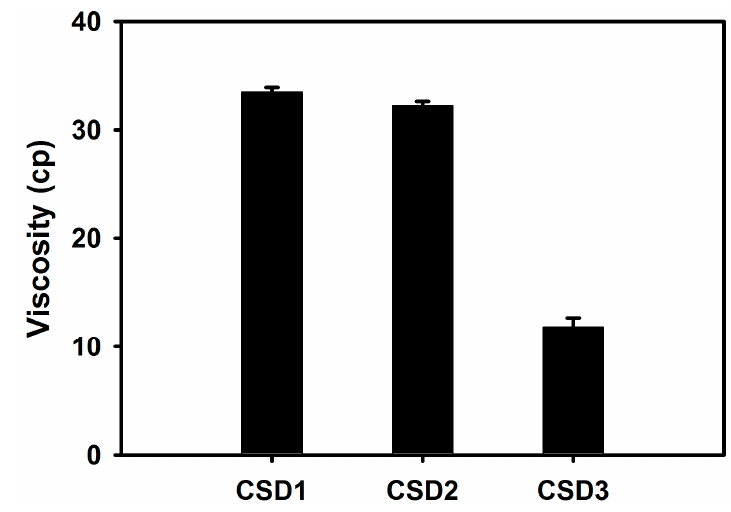
Figure 8. The viscosity of the dispersion of CSD (2%, w / v ) in water. Data are presented as means ± standard deviation ( n = 3).